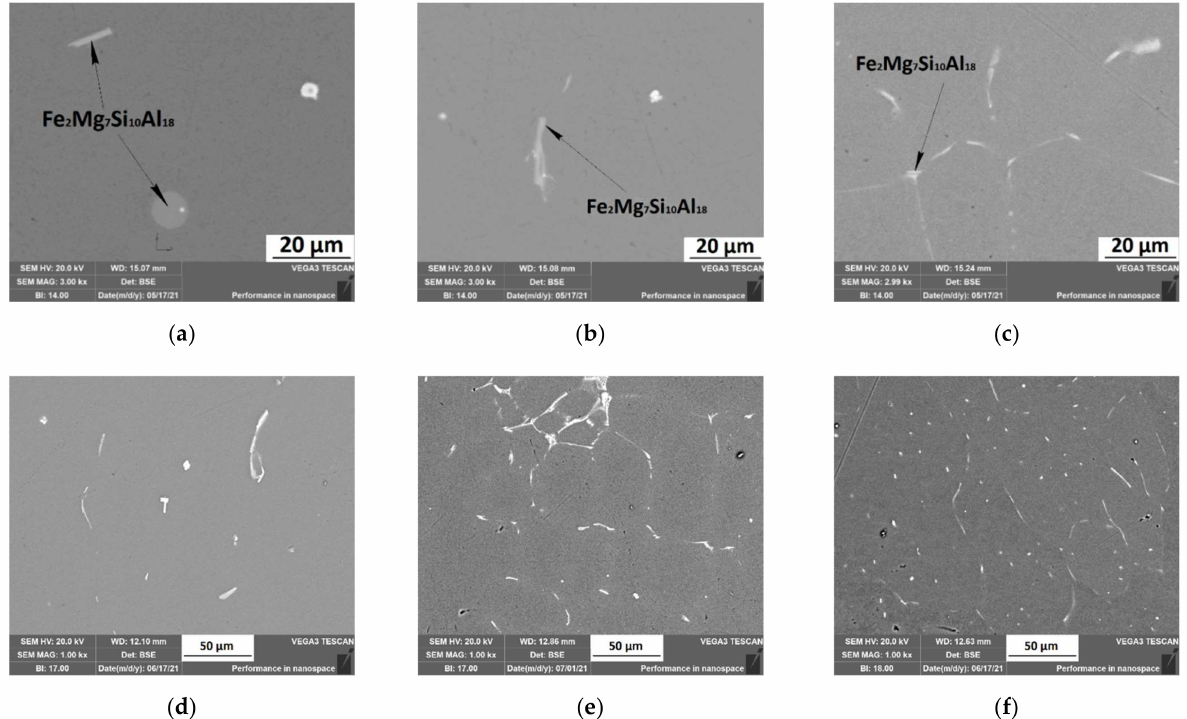
Figure 6. Micrographs of Al 0.3 Mg 1 Si alloy. Phases: ( a ) steel chill mold; ( b ) copper chill mold; ( c ) copper chill mold of round section. Intermetallic compounds: ( d ) steel chill mold; ( e ) copper chill mold; ( f ) copper chill mold of round